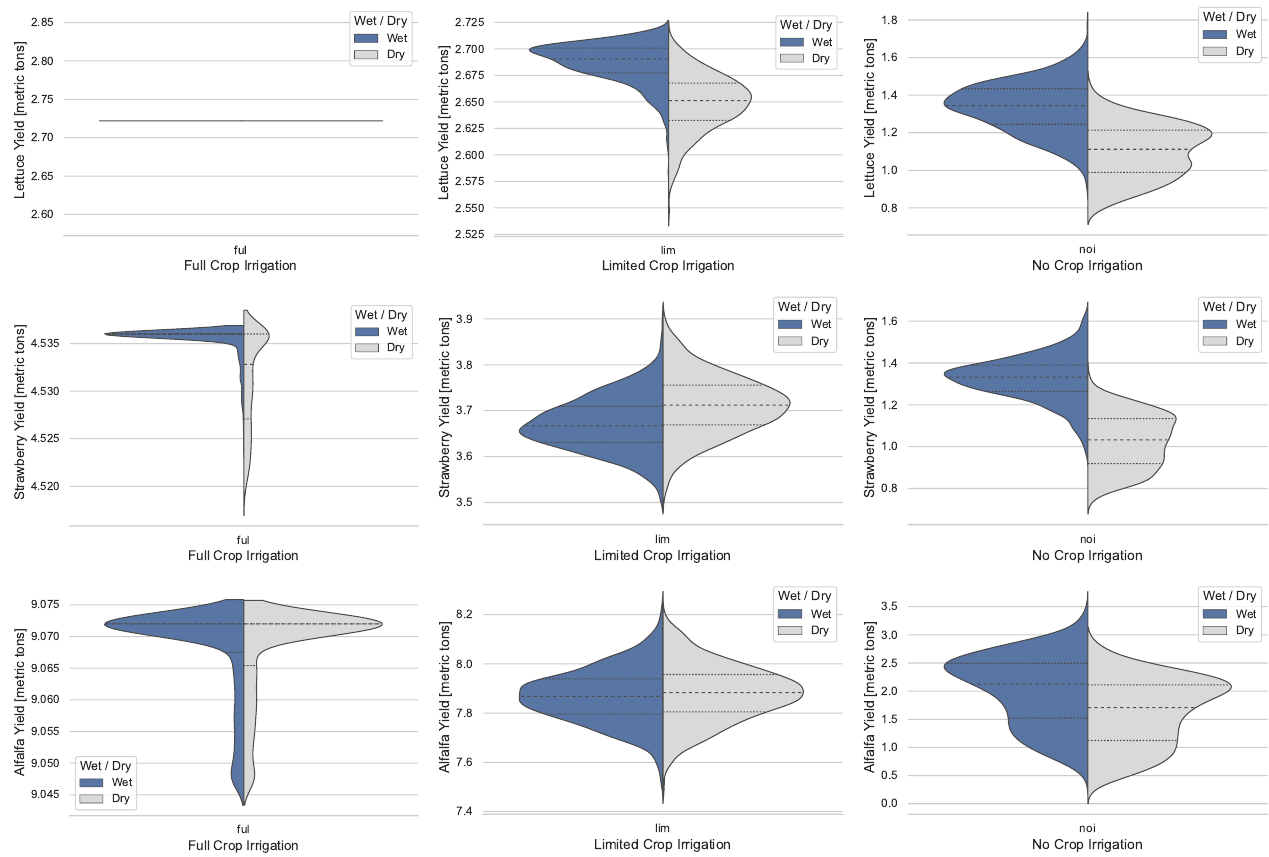
Figure 8. Distributions of annual yield (in metric tons) for alfalfa, strawberries, and lettuce under all three irrigation strategies: full (ful), limited (lim), and no irrigation (noi). Both wet and dry forecasts were used; yields were maximized under full irrigation. Average yields were cut in half when no irrigation was